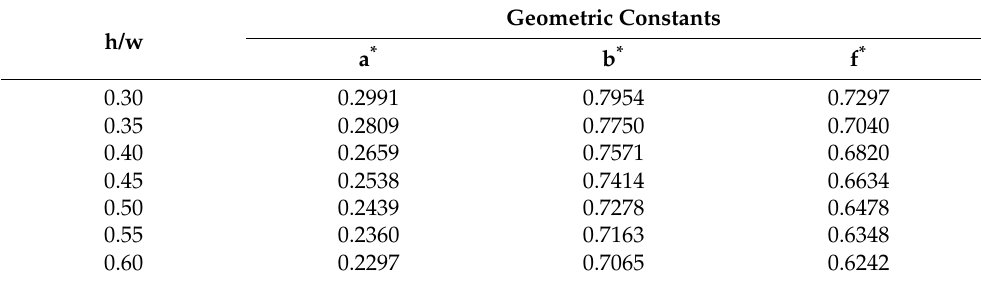
Table 1. The geometric parameters a * , b * , and f * of rectangular die model for calculating shear rate [35]. h/w Geometric Constants h/w a *